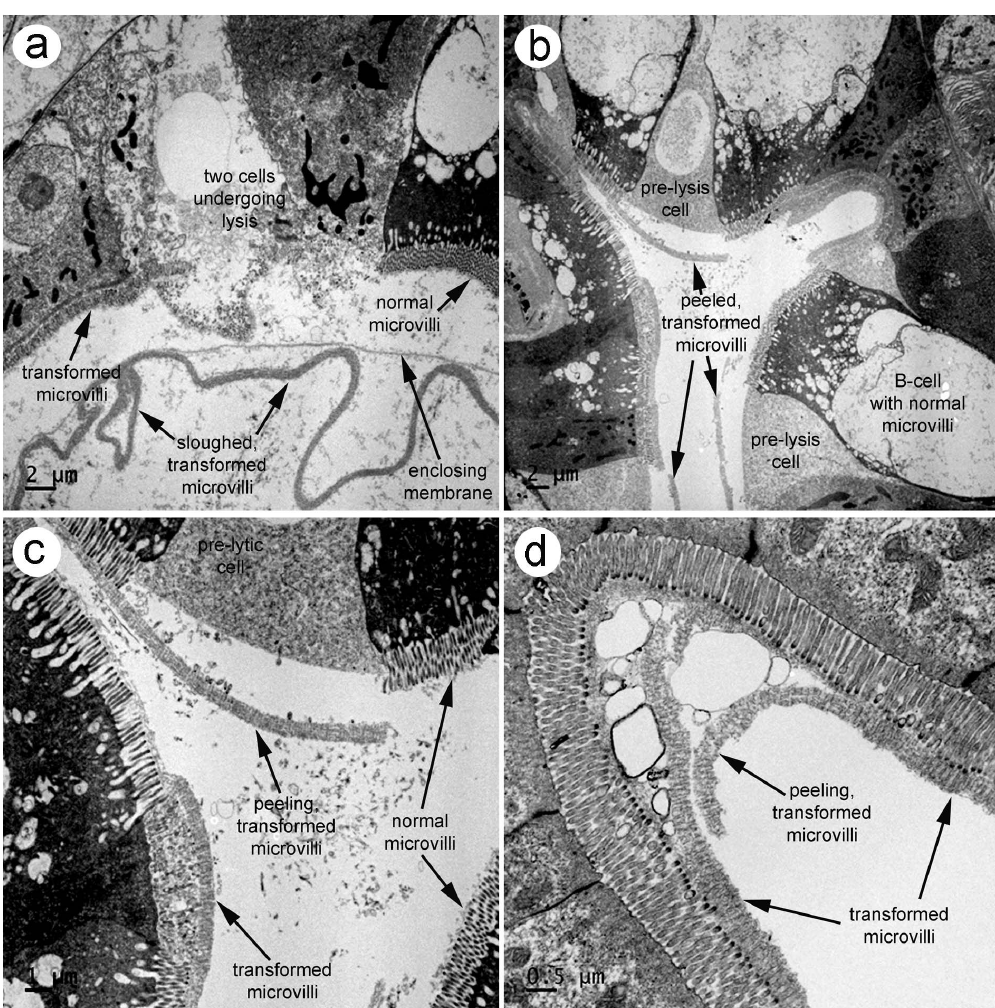
Figure 7. TEM of steps in microvillar transformation and sloughing. (a) Low magnification of HP tubule epithelial cells showing normal and transformed microvilli and two denuded cells undergoing lysis. Also shown is an early stage in the aggregation of transformed and sloughed microvilli surrounded by an enclosing membrane. (b) Low magnification of HP tubule epithelial cells with transformed microvilli peeling from the cell surface, prior to cell lysis. (c) Higher magnification of the field from (b) clearly showing the difference between normal and transformed microvilli. (d) High magnification of HP tubule epithelial cells showing the tubular nature of transformed and peeled microvillar layers.